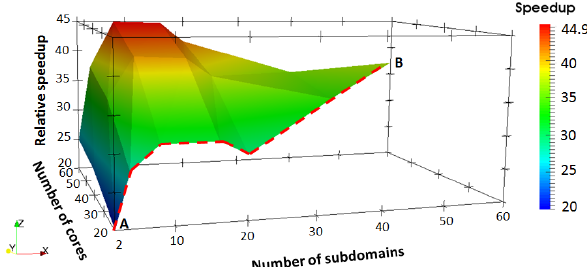
Figure 12. Relative speedup to serial simulation as a function of the number of DDCs and compute